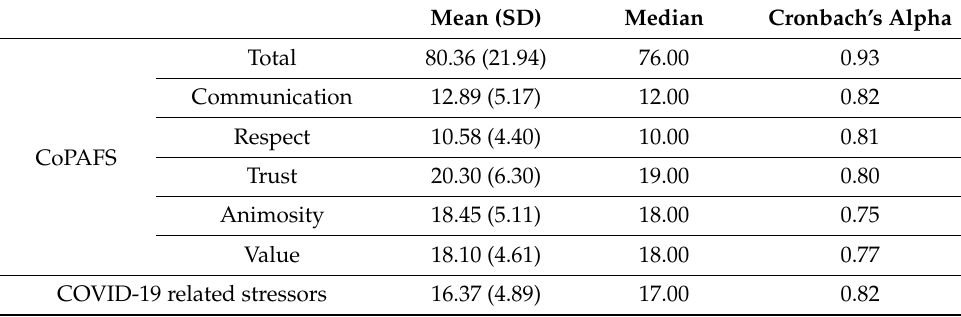
Table 1. Measures of central tendency and internal validity